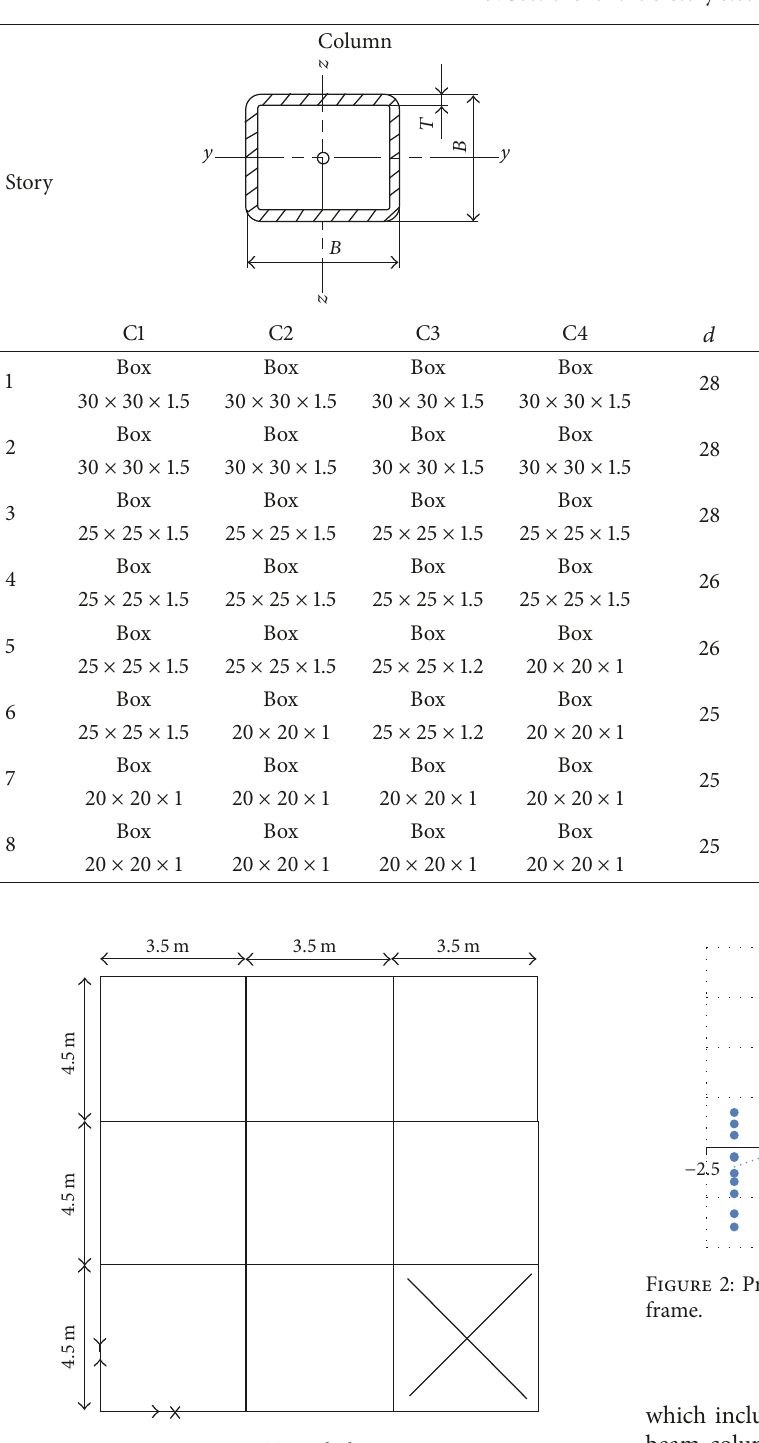
Table 9: Sections for the 8-story steel frame.